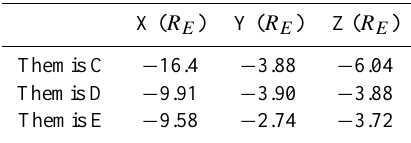
Table 1. Positions of Themis C, D and E in GSM at 06:02UT, 11 January